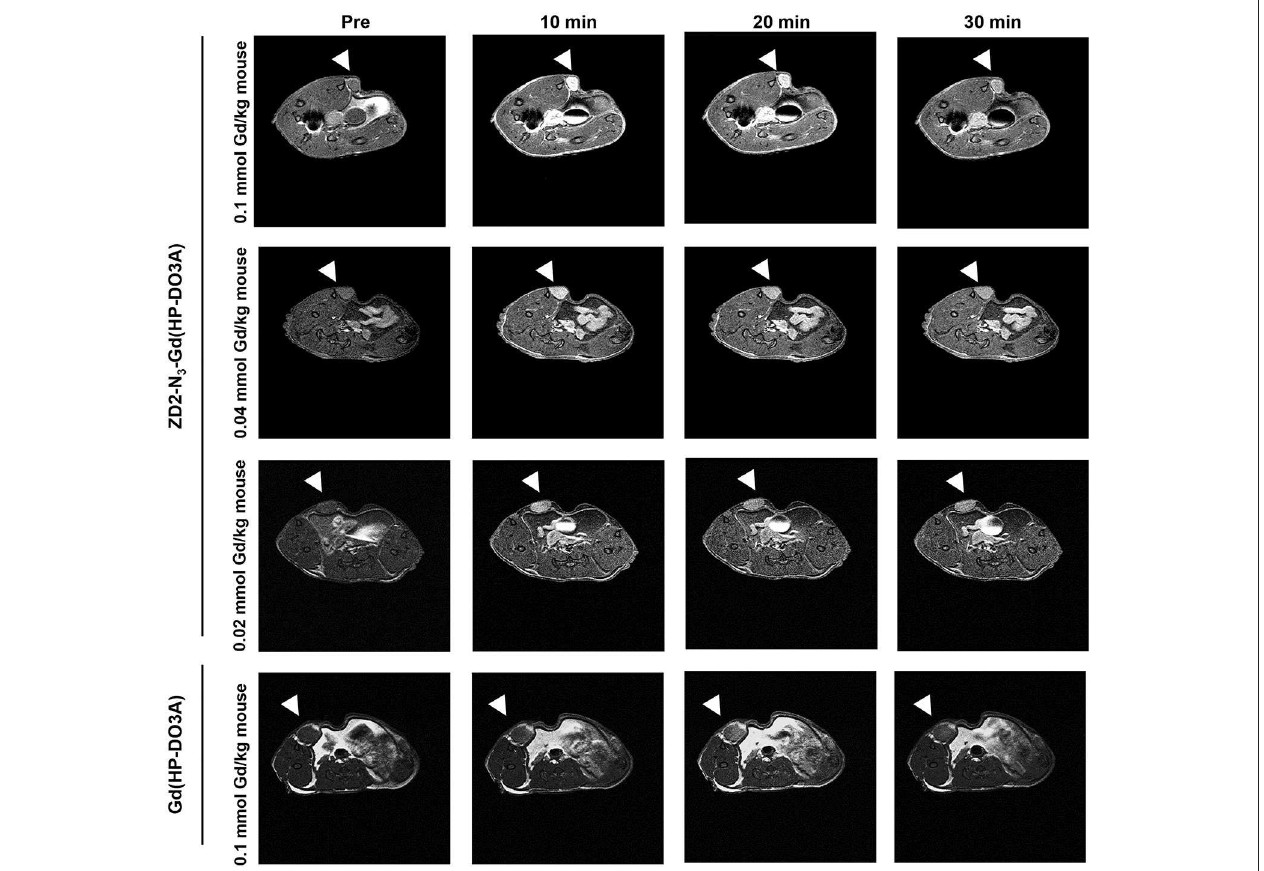
FIGURE 3 | MRMI with MT218 of Hs578T tumors in mice. Representative axial T 1 -weighted 2D fast spin echo images taken before and at 10, 20, and 30min post-injection of MT218 at doses of 0.1, 0.04, and 0.02 mmol Gd/kg mouse. Tumors are indicated by the white arrow heads. The clinical agent Gd(HP-DO3A) was used as a control at 0.1 mmol